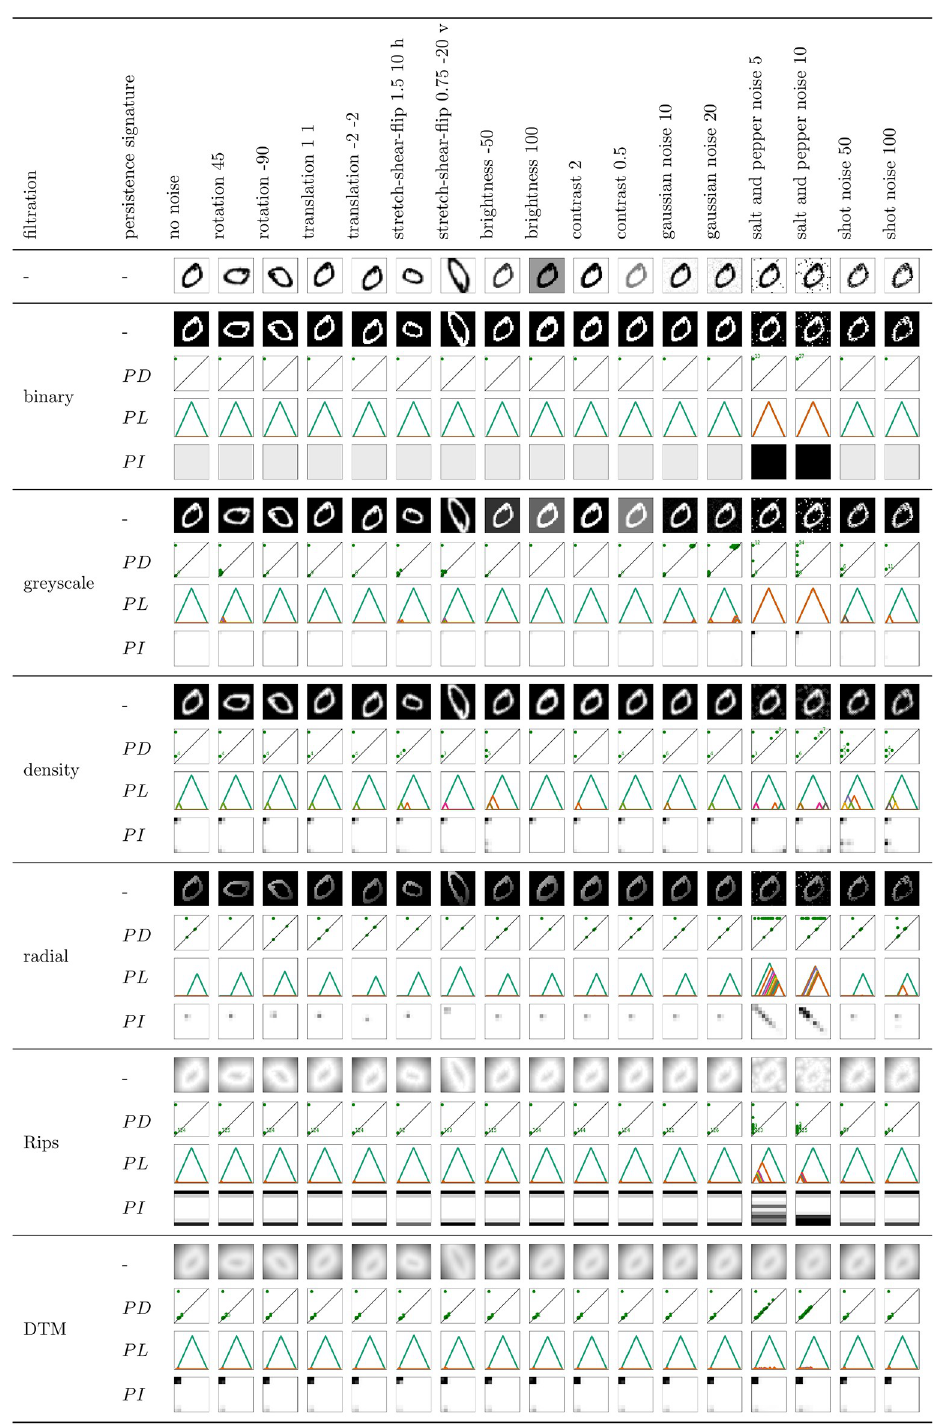
Fig 5. Noise robustness of 0-dimensional persistent homology on an example image. Illustration of the effect of various image transformations when the image is represented with its filtration function values (1st row of each filtration), or 0-dimensional persistence diagram (2nd row), persistence landscape (3rd row), or persistence image (4th row).